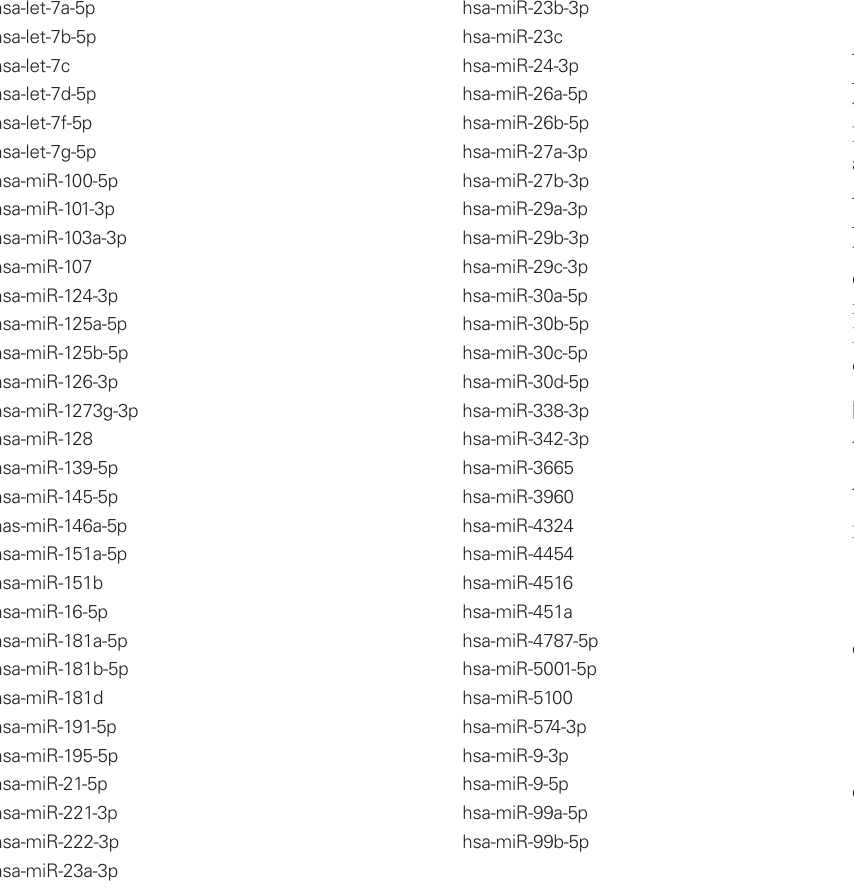
Table 1 | Most abundant miRNAs in the human brain temporal lobe association neocortex; ranked by miRNA numerical designation; based on pooled data from N = 21 short post-mortem interval (PMI) controls; this group included 9 males and 12 females, mean age 72 ± 6.3 years; all PMIs less than 3 h; all of these miRNAs yielded a relative signal strength of 5000 or greater on an LC Sciences miRNA array Genechip (proprietary MRA-1001-miRNA microfluidic chip analytical platform; 1922 small RNAs analyzed; LC Sciences Corporation, Houston, TX, USA) and ranked the top 61 of most abundant miRNAs detected; except for miRNAs listed here, all other miRNAs are in a significantly lower abundance; note high basal abundance of the let-7a to let-7g group of miRNAs; note that AD-abundant miRNAs such as miRNA-155 do not appear in this table as in control brain they are relatively scarce, but are significantly induced as in AD brain, and especially as AD